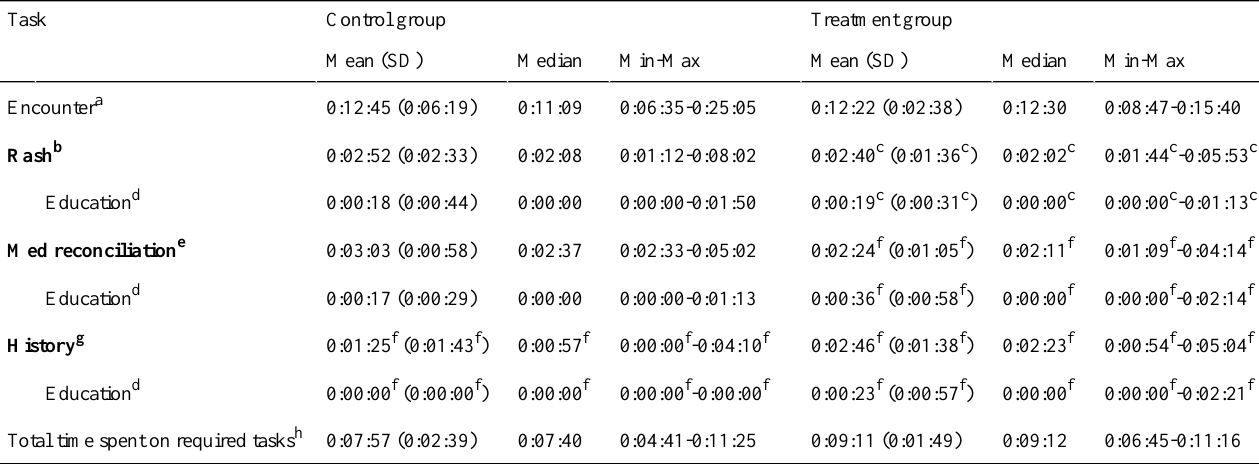
Table 7. Descriptive statistics for encounter and task times for the 6 participants in the control group and 6 participants in the treatment group.